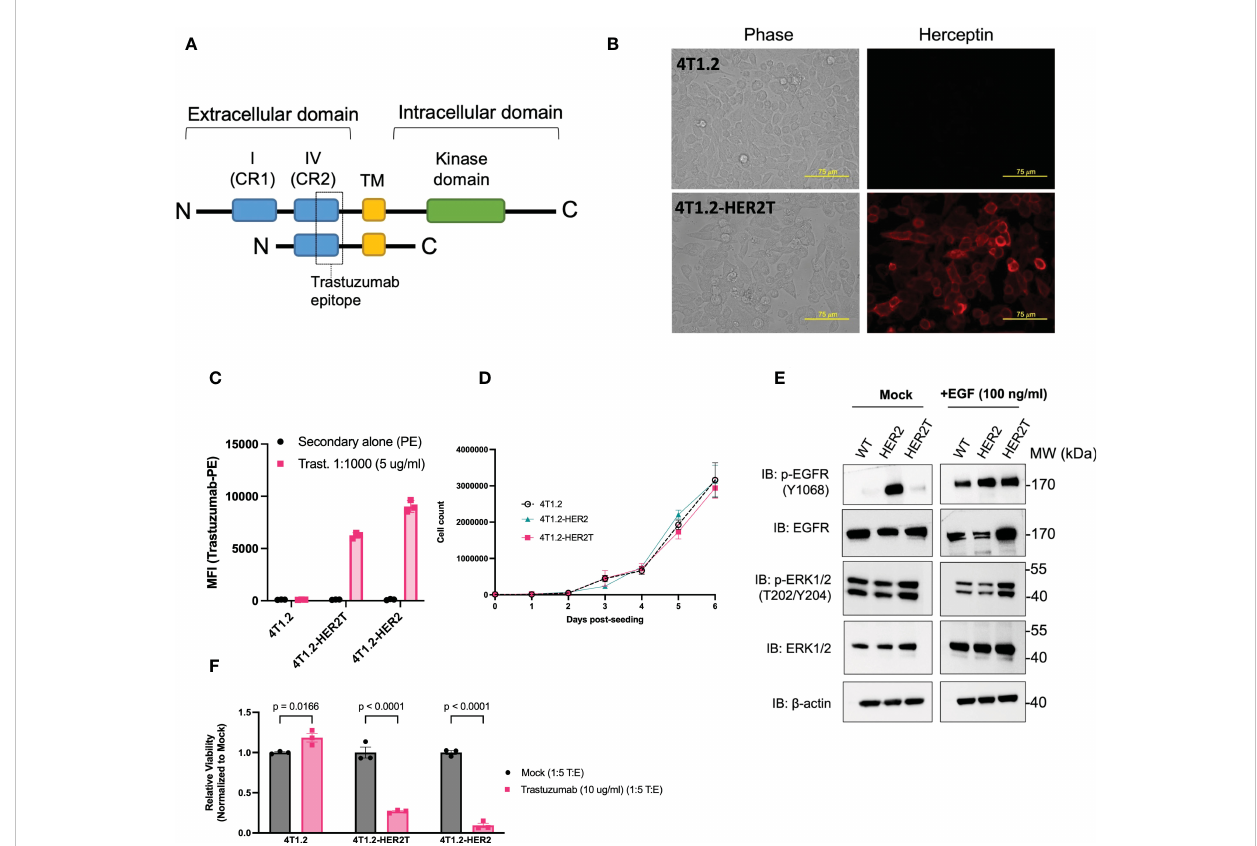
FIGURE 2 4T1.2 cells expressing HER2T bind to trastuzumab in vitro. (A) Diagrammatic representation of HER2T design (B) 4T1.2 and 4T1.2-HER2T cells were seeded on glass coverslips, fi xed and stained with trastuzumab (1:1000), and visualized with Alexa Fluor 594-conjugated goat anti-human IgG secondary antibody. (20x magni fi cation). (C) 4T1.2, 4T1.2-HER2T, and 4T1.2-HER2 cells were stained using trastuzumab (1:1000), followed by staining with PE-conjugated goat anti-human IgG secondary antibody. Geometric mean fl uorescence intensity was obtained by fl ow cytometric analysis (geometric mean ± SEM; n = 3) (D) 7-day proliferation assay for 4T1.2, 4T1.2-HER2, 4T1.2-HER2T cells (mean ± SEM; n = 3) (E) Cells from (D) were plated and serum starved for 12 hours as indicated, followed by stimulation with EGF 100 ng/ml for 45 minutes as indicated. Whole cell lysates were extracted and resolved by PAGE and probed as shown. (F) Indicated cell lines were co-cultured with NK-92MI CD16a+ cells. Remaining target cells were stained with Coomassie blue, solubilized, and quanti fi ed at absorbance 595 nm (mean ± SEM; n=3; two-way ANOVA, Sidak ’ s correction for multiple